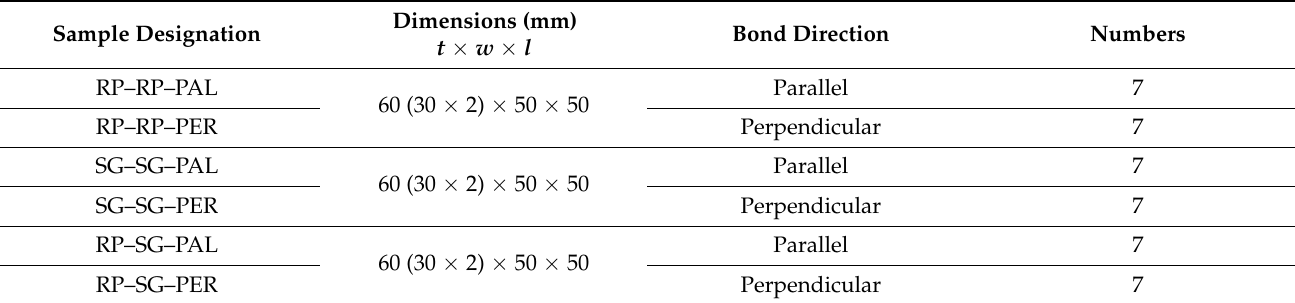
Figure 2. Lamellae preparation, clamping process and fi nal specimens for testing. Table 2. Details of samples’ dimensions for testing. Table 2. Details of samples’ dimensions for testing.